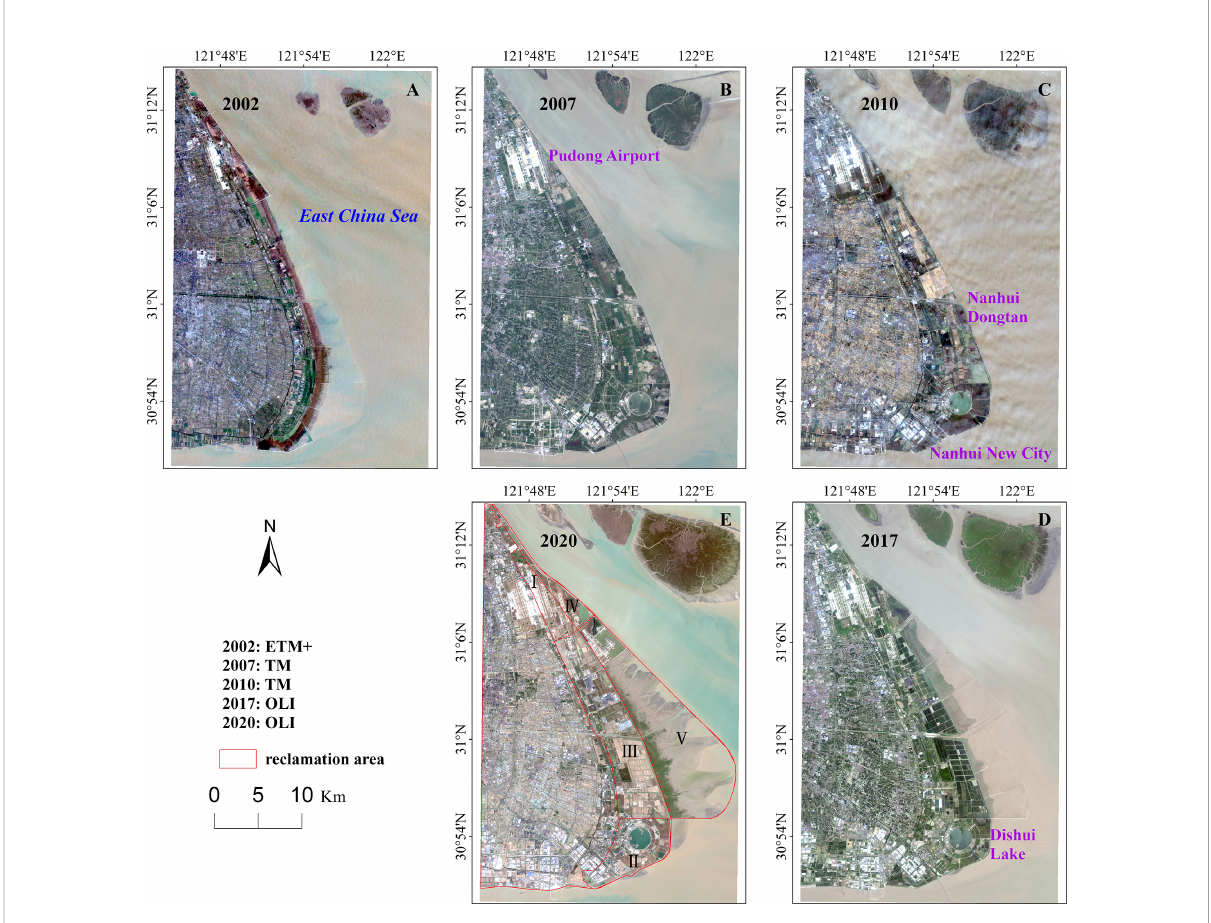
FIGURE 2 Satellite monitoring of land reclamation along the east coast of Shanghai from 2002 to 2020 (A – E) . The reclamation projects, including (1) Pudong Airport Reclamation Project (1995-2001), (2) Lingang New City Reclamation Project (1999-2004), (3) Reclamation Project outside Pudong Airport (1999-2006), (4) Nanhui Dongtan Reclamation Project (2007-2009) and (5) the Second Phase Project of Nanhui Dongtan Reclamation (2016-2020), are represented by Project I, II, III, V and VI, respectively in (E)